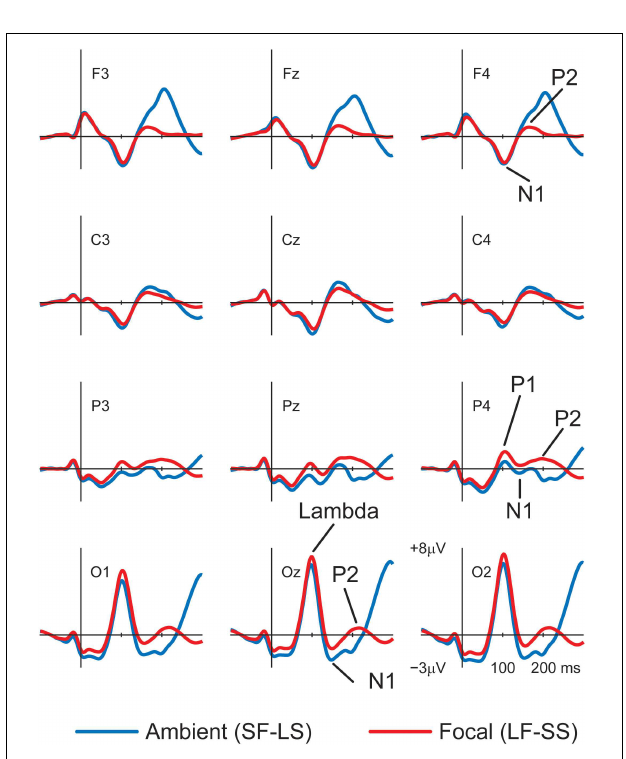
FIGURE 2 | Grand average EFRP waveforms from 62 participants generated separately for fixations belonging to focal (see red line) and ambient (see blue line)